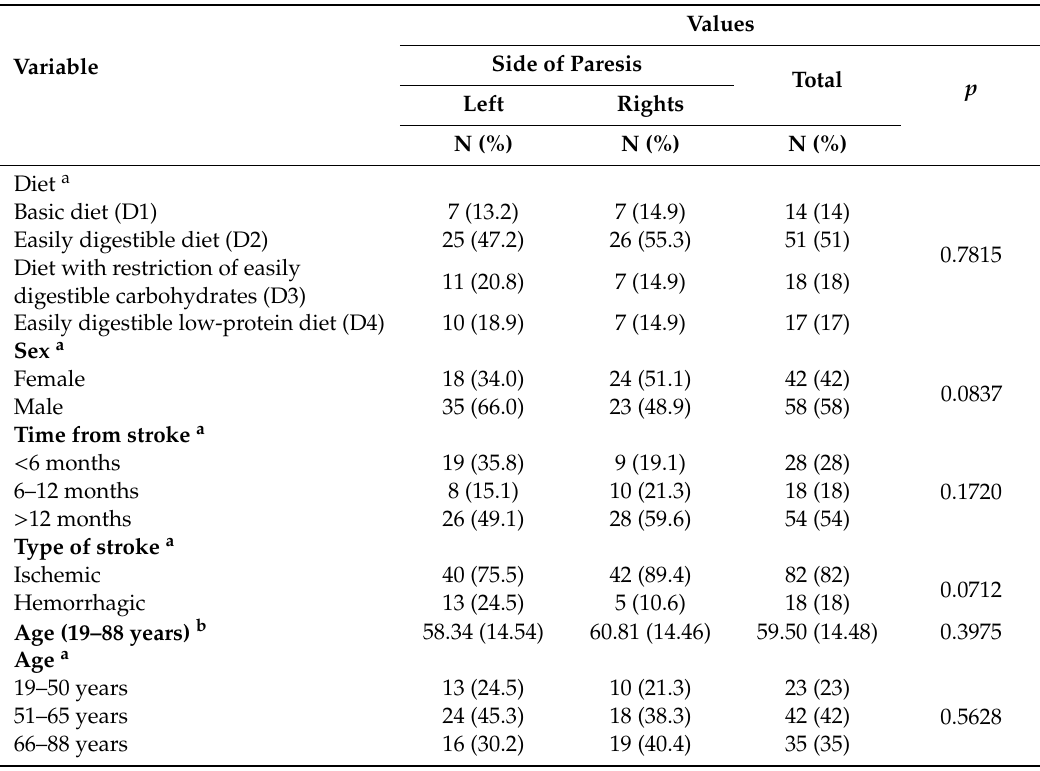
Table 1. Characteristics of the study